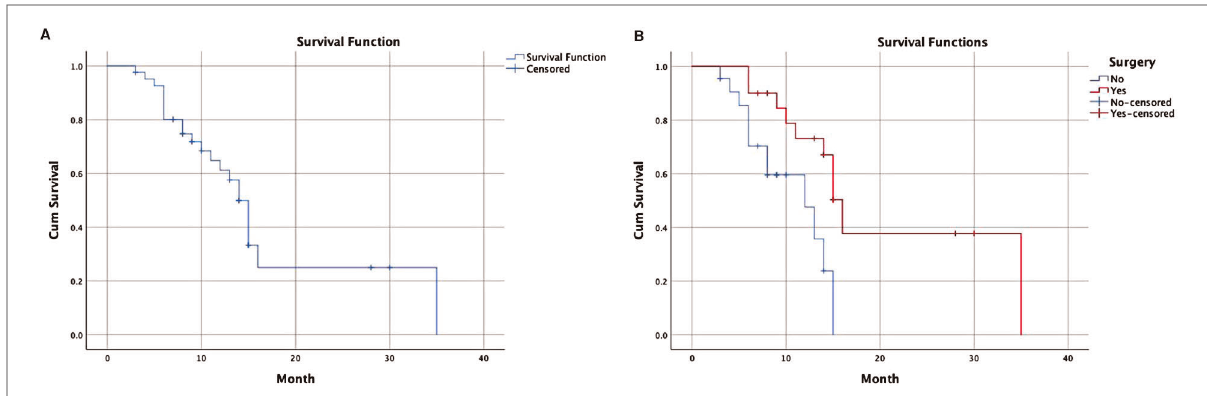
FIGURE 2 Survival analysis of patients underwent GTC. ( A ) A Kaplan – Meier overall survival curve of all patents underwent GTC; ( B ) subgroup analysis of surgical treatment group compared with non-surgical treatment group. GTC, gastric transcatheter chemoembolization.